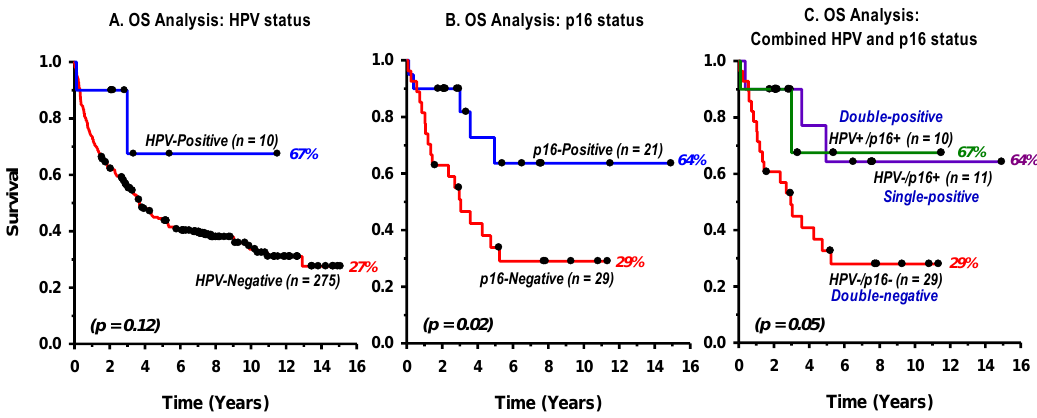
Figure 4. Kaplan – Meier Log-Rank overall survival (OS) analysis by HPV ( A ) status of head and neck squamous cell carcinomas in 285 cancer patients, p16INK4a ( B ), and the combination of HPV and p16INK4a ( C ) status in a subset of 50 cases. The p -value in ( C ) represents the overall significance level. There was no significant difference between single-positive and double-positive cases ( p = 0.85).